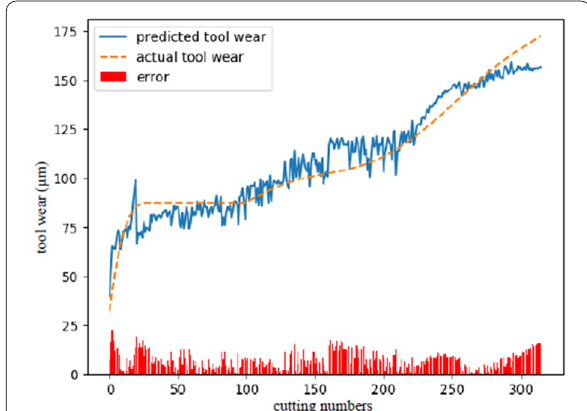
Figure 11 Results of the first experimental case, when c 1 is the testing set: the prediction of the tool wear, the corresponding actual tool wear, and the error between these two values